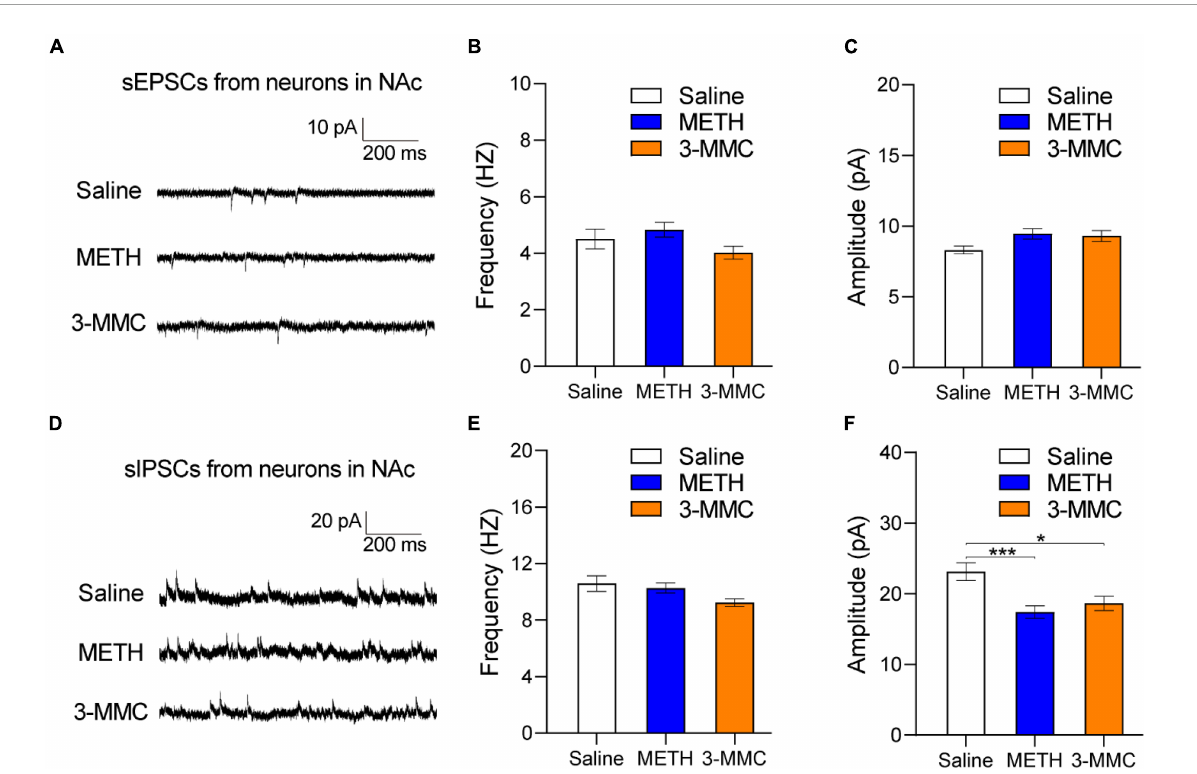
output of VTA neurons is NAc (Cooper et al., 2017).